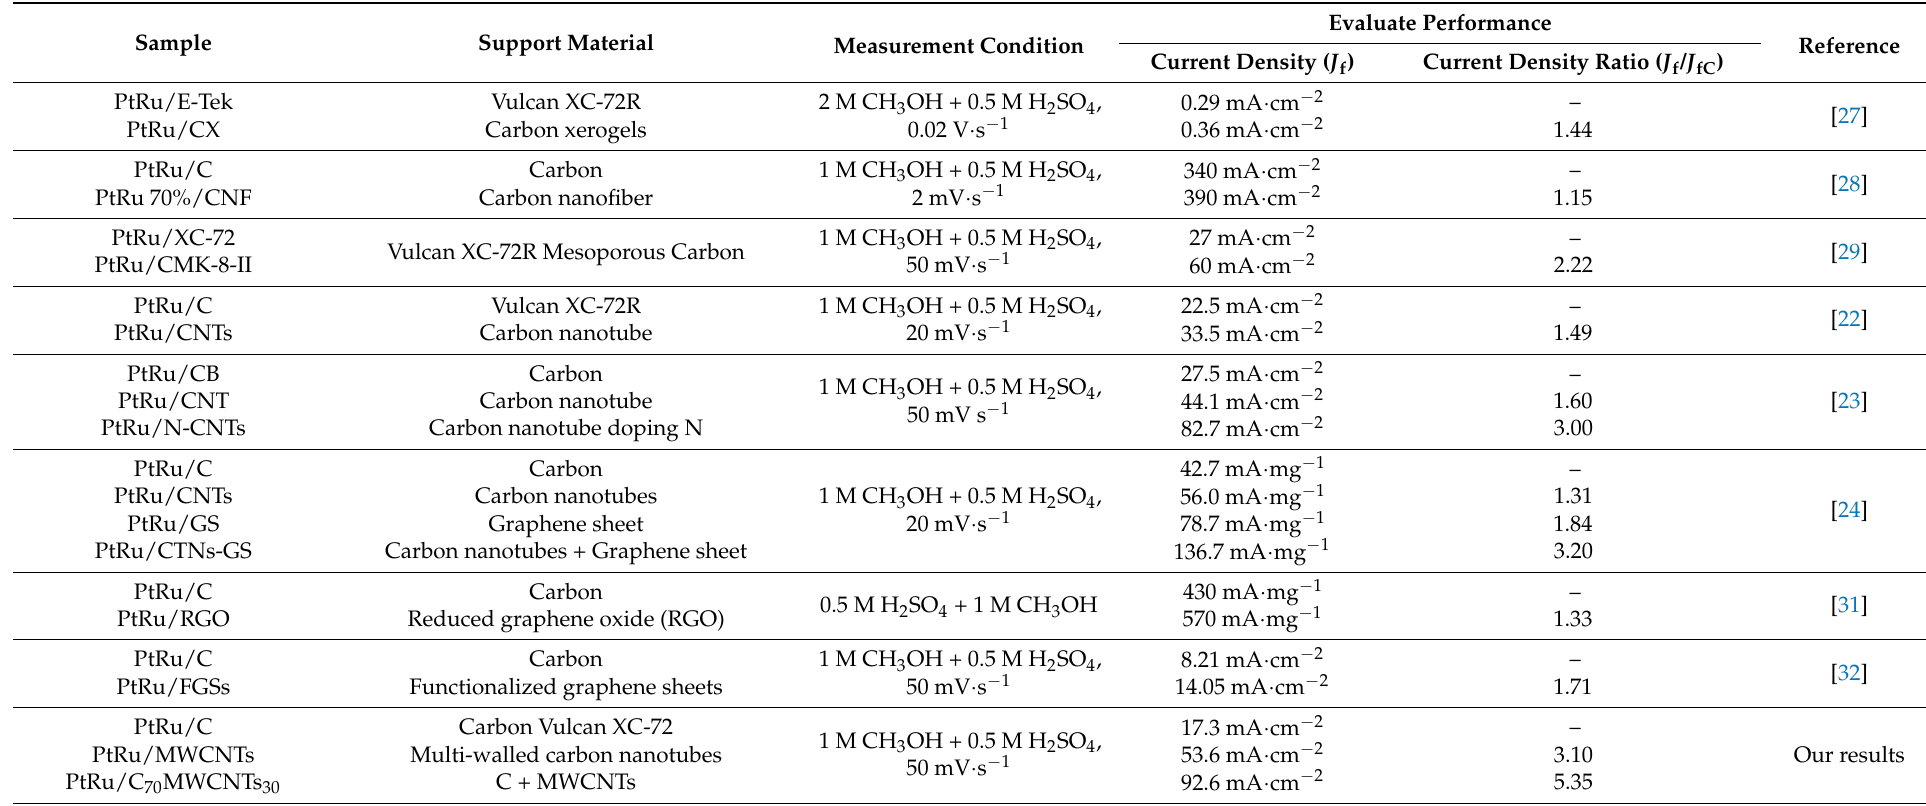
Table 4. Comparison of CV results of the selected studies of PtRu nanoparticles decorated on novel carbon-related substrates in the literature and in this study. Current density ratio ( J f / J fC ) is the ratio between J f of a PtRu/modified support and the J f of a PtRu/conventional carbon support in each reference and in this